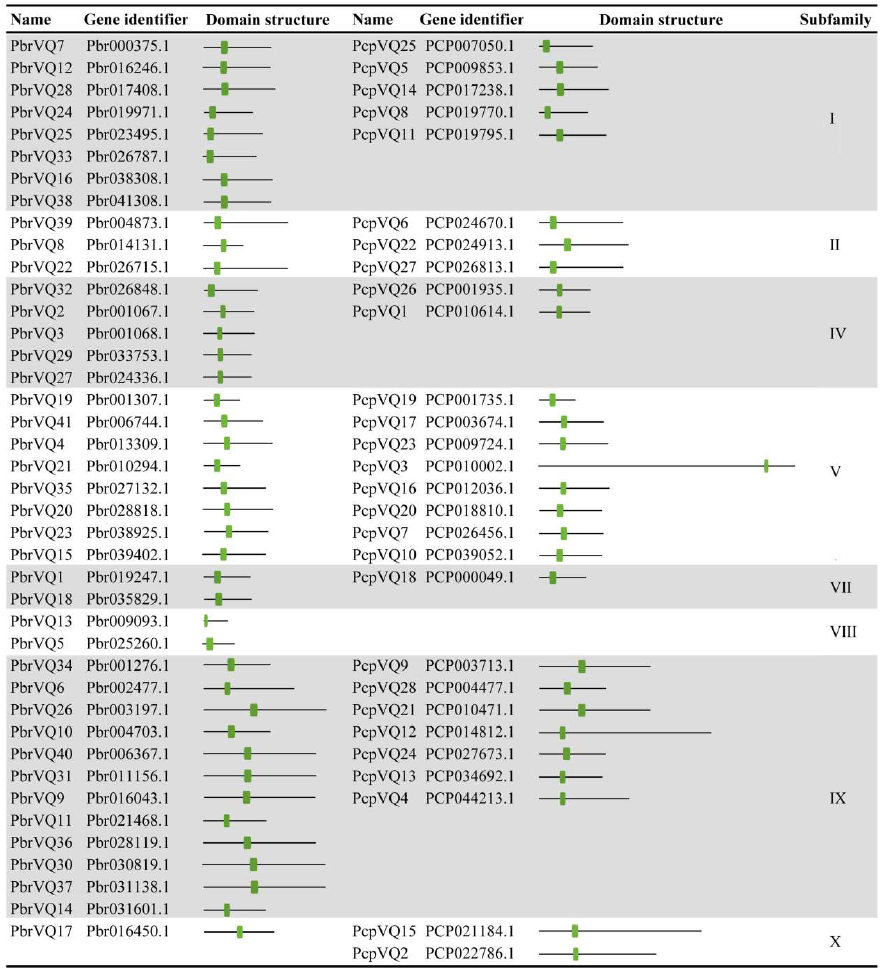
Figure 1. Summary of Pyrus bretschneideri and Pyrus communis VQ motif-containing genes. The classification information of VQ motif-containing genes was extracted from previously published articles [9]. The VQ domain is indicated in green.